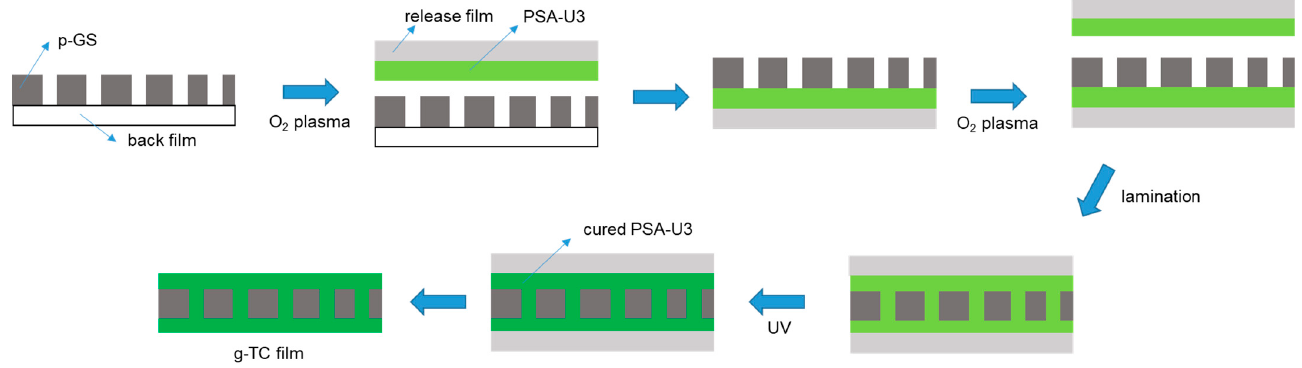
Figure 1. Schematic process for fabrication of a g − TC film .